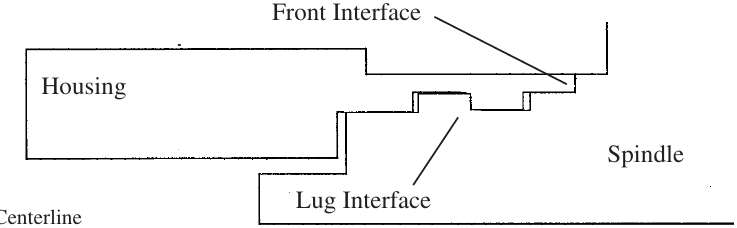
Fig. 2. Detail of the housing to spindle